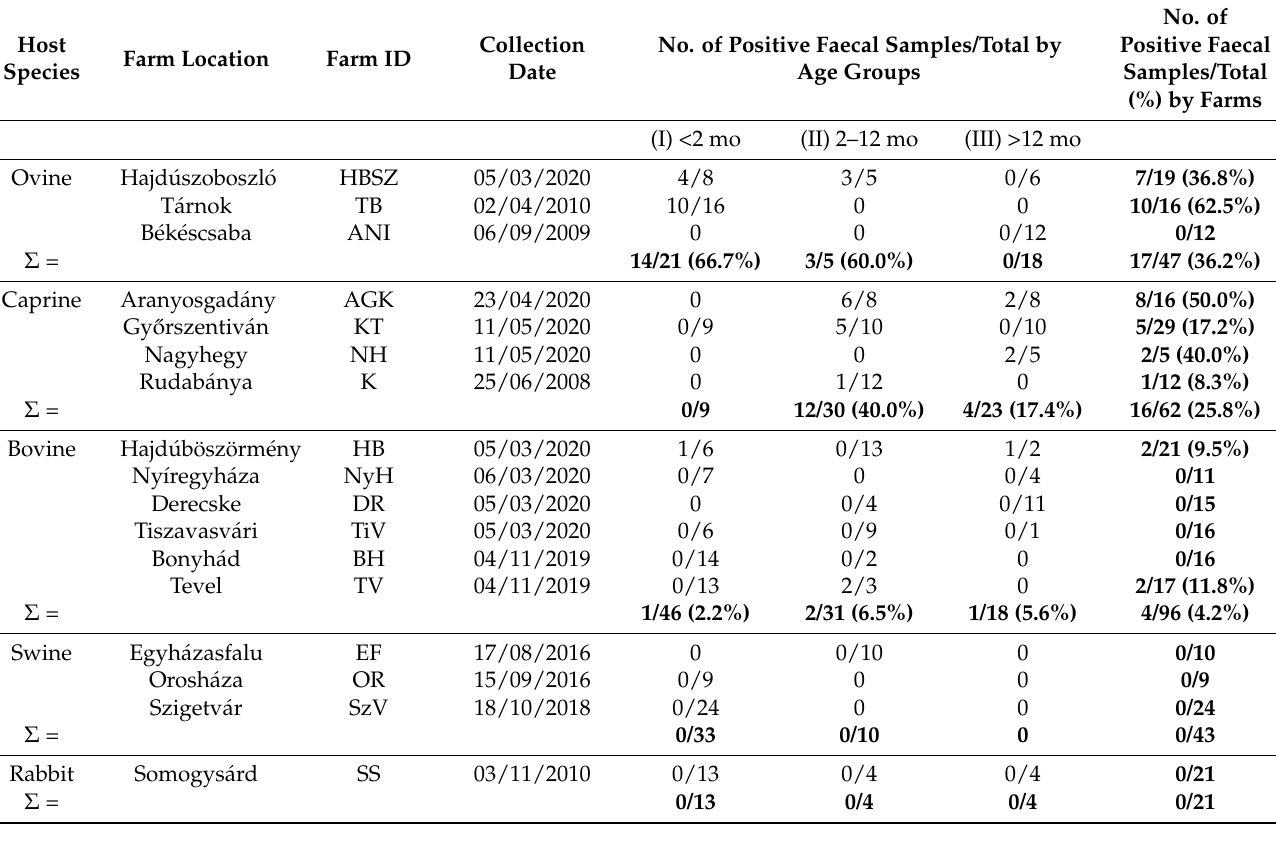
Table 1. Origin and features of sampled animals (hosts) as well as statistic data of bopivirus prevalence (in bold ). Positive